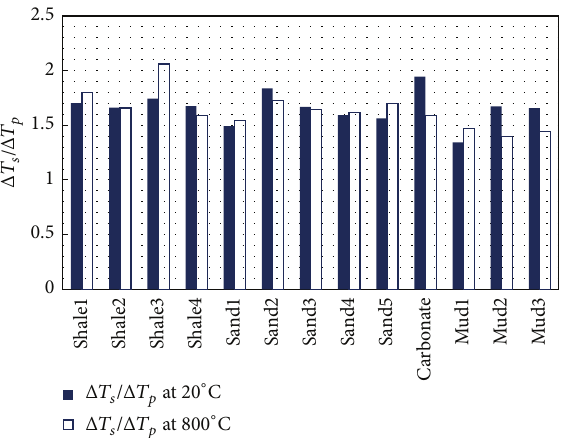
Figure 4: Ratio of Δ𝑇 𝑠 to Δ𝑇 𝑝 at 20 ∘ C and 800 ∘ C for all the samples.